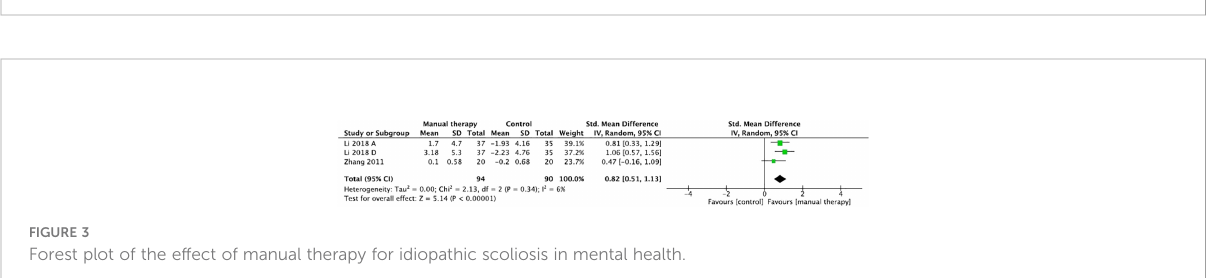
FIGURE 3 Forest plot of the effect of manual therapy for idiopathic scoliosis in mental health.